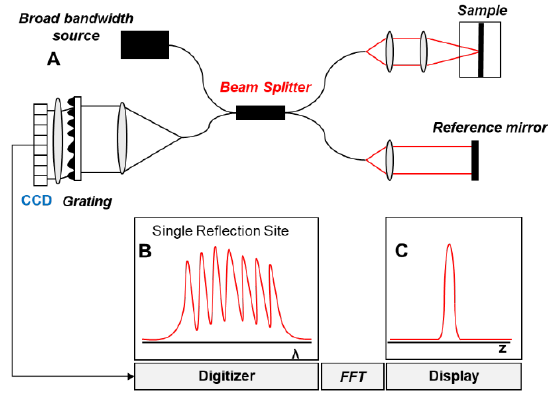
Figure 2. ( A ) Fiber-optic implementation of Fourier domain low coherence interferometer, ( B ) spec- trogram and ( C ) back reflection profile.